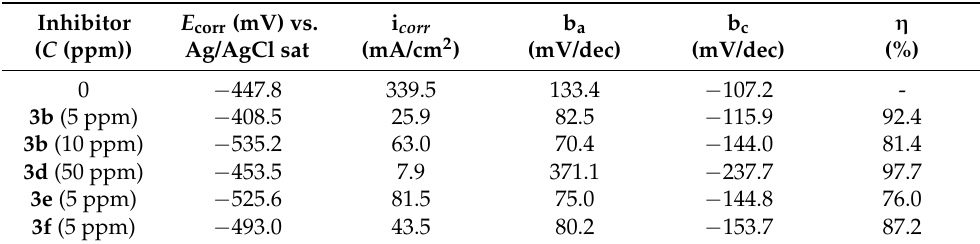
Table 2. Electrochemical parameters by CP at different concentrations in API 5L X70 immersed in HCl 1